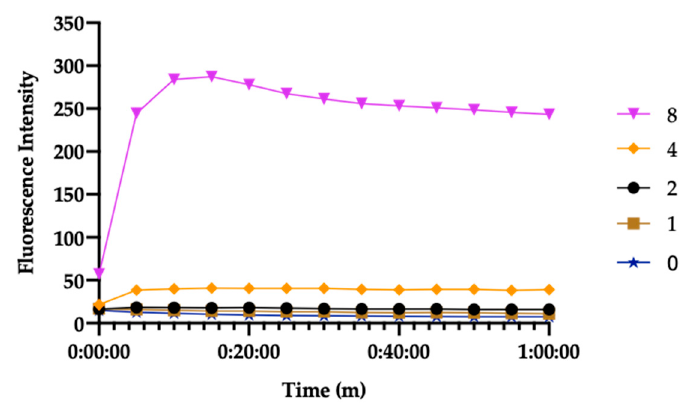
Figure 6. IMD0354 induces membrane permeabilization at high concentrations. VRS1 membrane permeabilization was measured spectrophotometrically by monitoring the uptake of SYTOX Green (excitation wavelength of 485 nm and an emission wavelength of 525 nm) during treatment with IMD0354 at various concentrations. The legend units are µg/mL. Each assay was tested in triplicate. ( n = 3, ± S.D). Error bars are omitted for clarity.